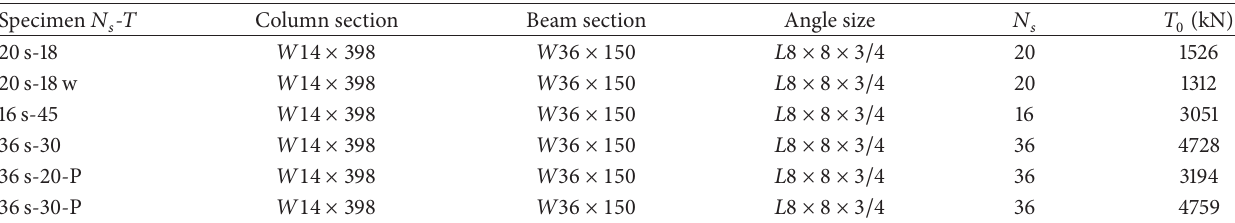
Table 1: Test matrix (Garlock et al.) [3].